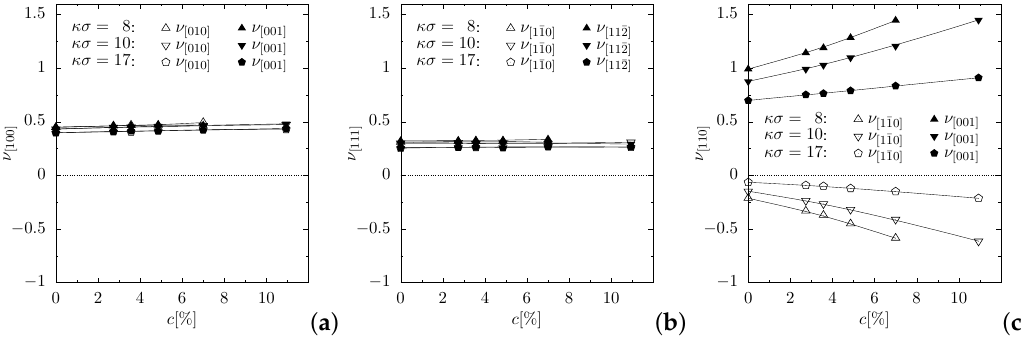
Figure 5. Poisson’s ratio of Yukawa crystals with nanochannels in the main crystallographic directions with respect to the concentration: ( a ) [ 100 ] ; ( b ) [ 111 ] ; and ( c ) [ 110 ]